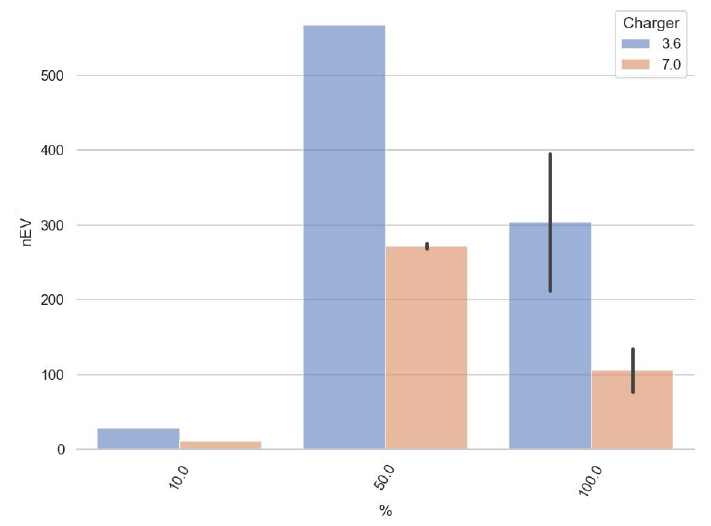
Figure 10. Medium voltage HC—Feeder